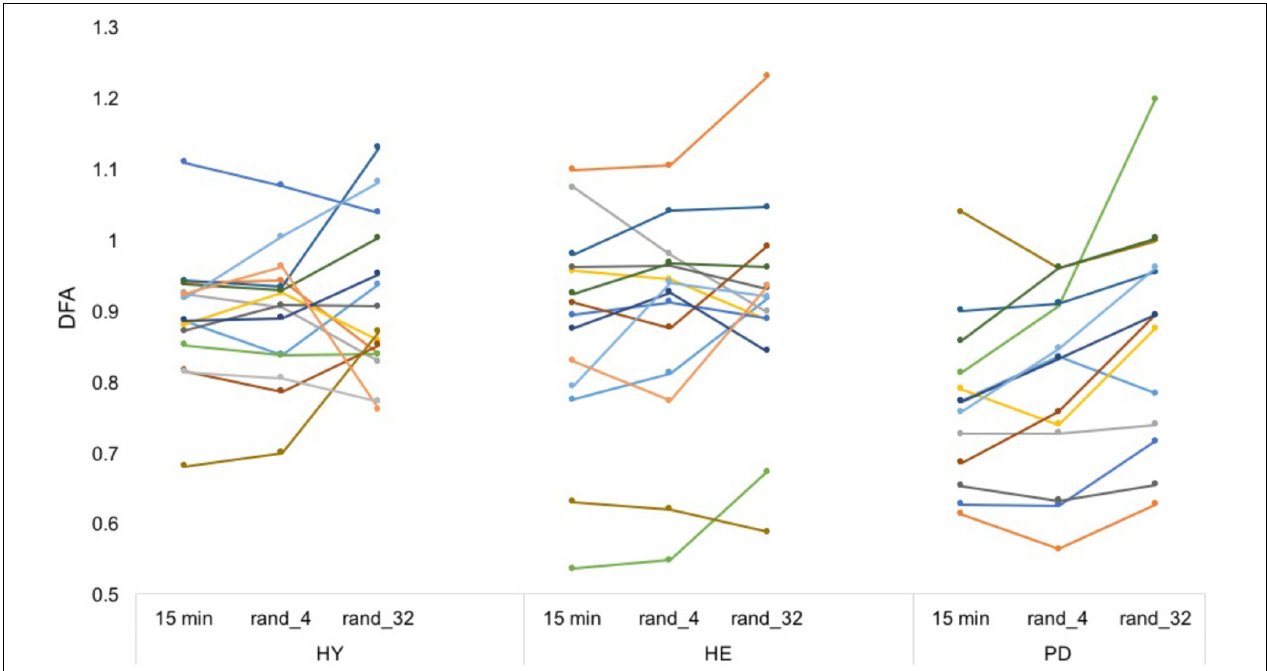
FIGURE 4 | Artificially stitched individual DFA values. Each color represents a participant. From a simple visual inspection, DFA values seem rather reliable between conditions (in contrast to Figure 3 ). Note that the procedure was repeated 20 times to enhance the estimations. Intra-class correlation coefficients can be found in Supplementary Material